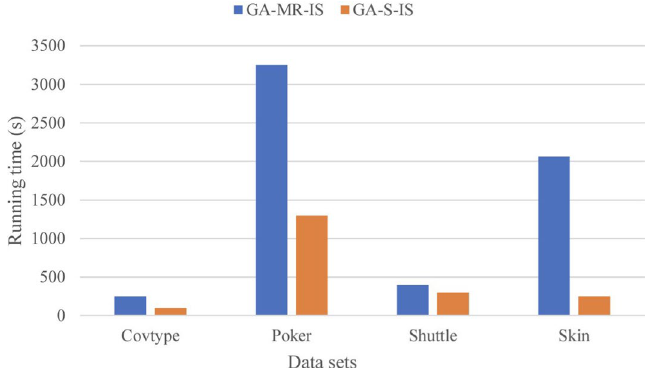
Fig. 9 The comparison of the running times of two